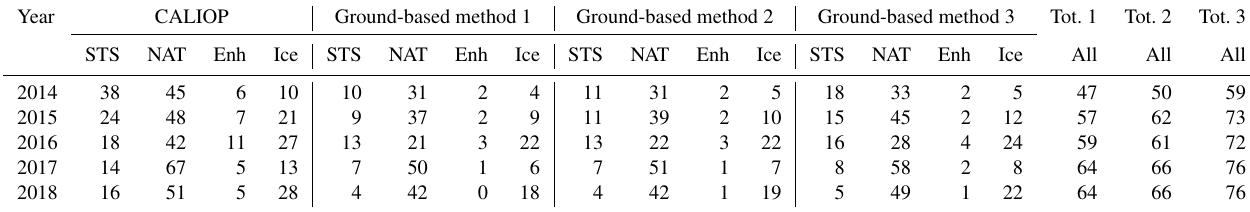
Table 3. The percentage of the different PSC composition classes are listed for CALIOP and ground-based observations following the three methods explained in the text. The last three columns are the percentages of correctly classified PSCs with respect to the CALIOP classification, according to the three